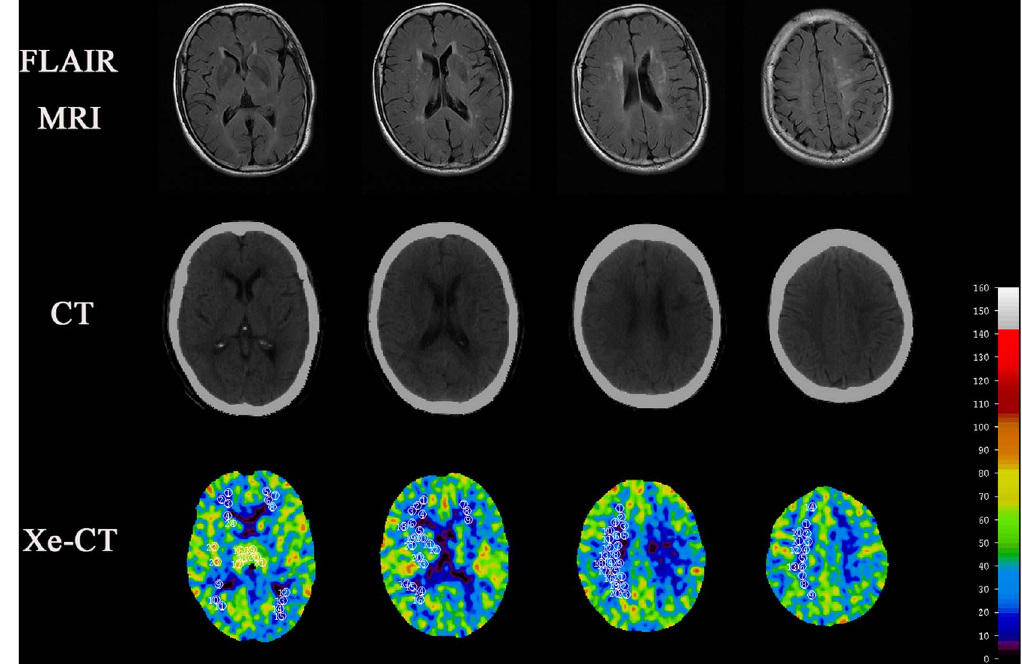
Figure 1. Flair imaging, normal CT and Xe-CT at different levels of subjects with WML.